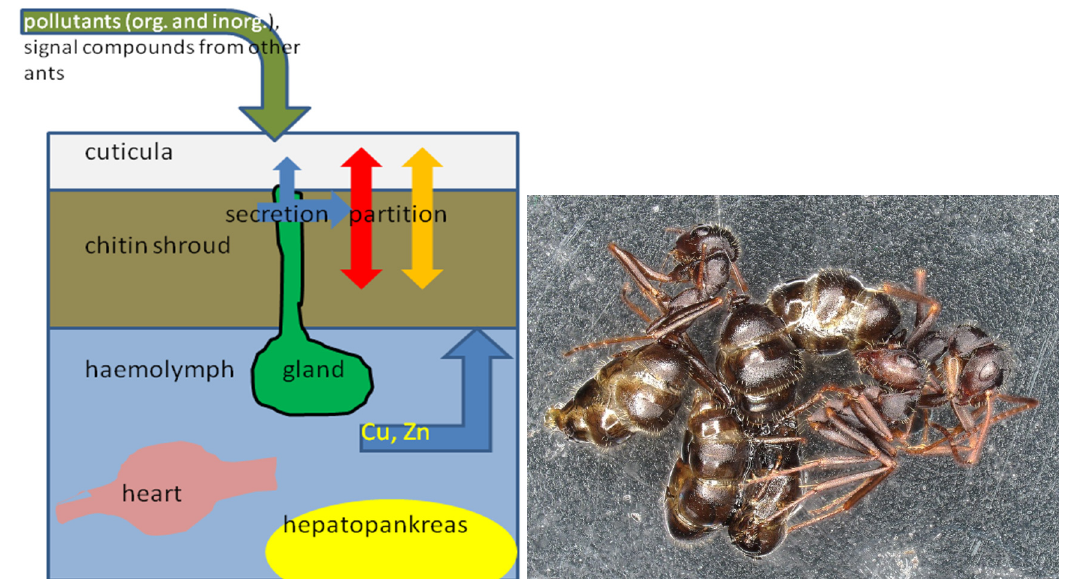
Figure 10. Left: cross-section of an ant showing the waxy cuticle absorbing non-polar organics and the underlying chitin layer with arrows indicating matter exchange equilibria. Inner organs of an ant were exposed to hemolymph liquid percolating the body freely, without blood vessels, while there was a heart, glands, and other organs (sketch by S.F.). Cu levels are very high due to hemocyanin transporting dioxygen in most arthropods, while Zn is very common in enzymes. Actual levels on chitin were 1–2 µg/g DM each. Ants shown in right photo (S.F.; [13,45]) were about 4 mm long.